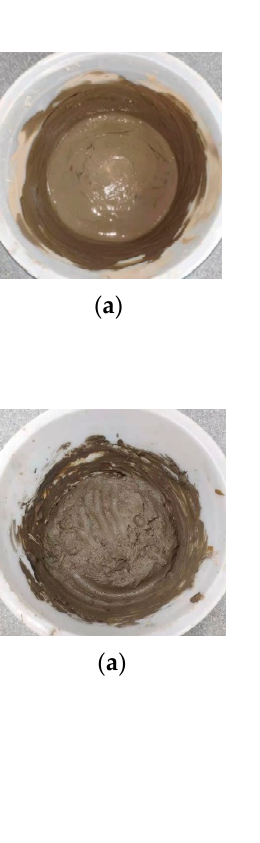
Figure 4. Curing effect of RCSLP solidified soil: ( a ) After 0.5 h; ( b ) After 1 h; ( c ) After 3 h; ( d ) After 6 h.